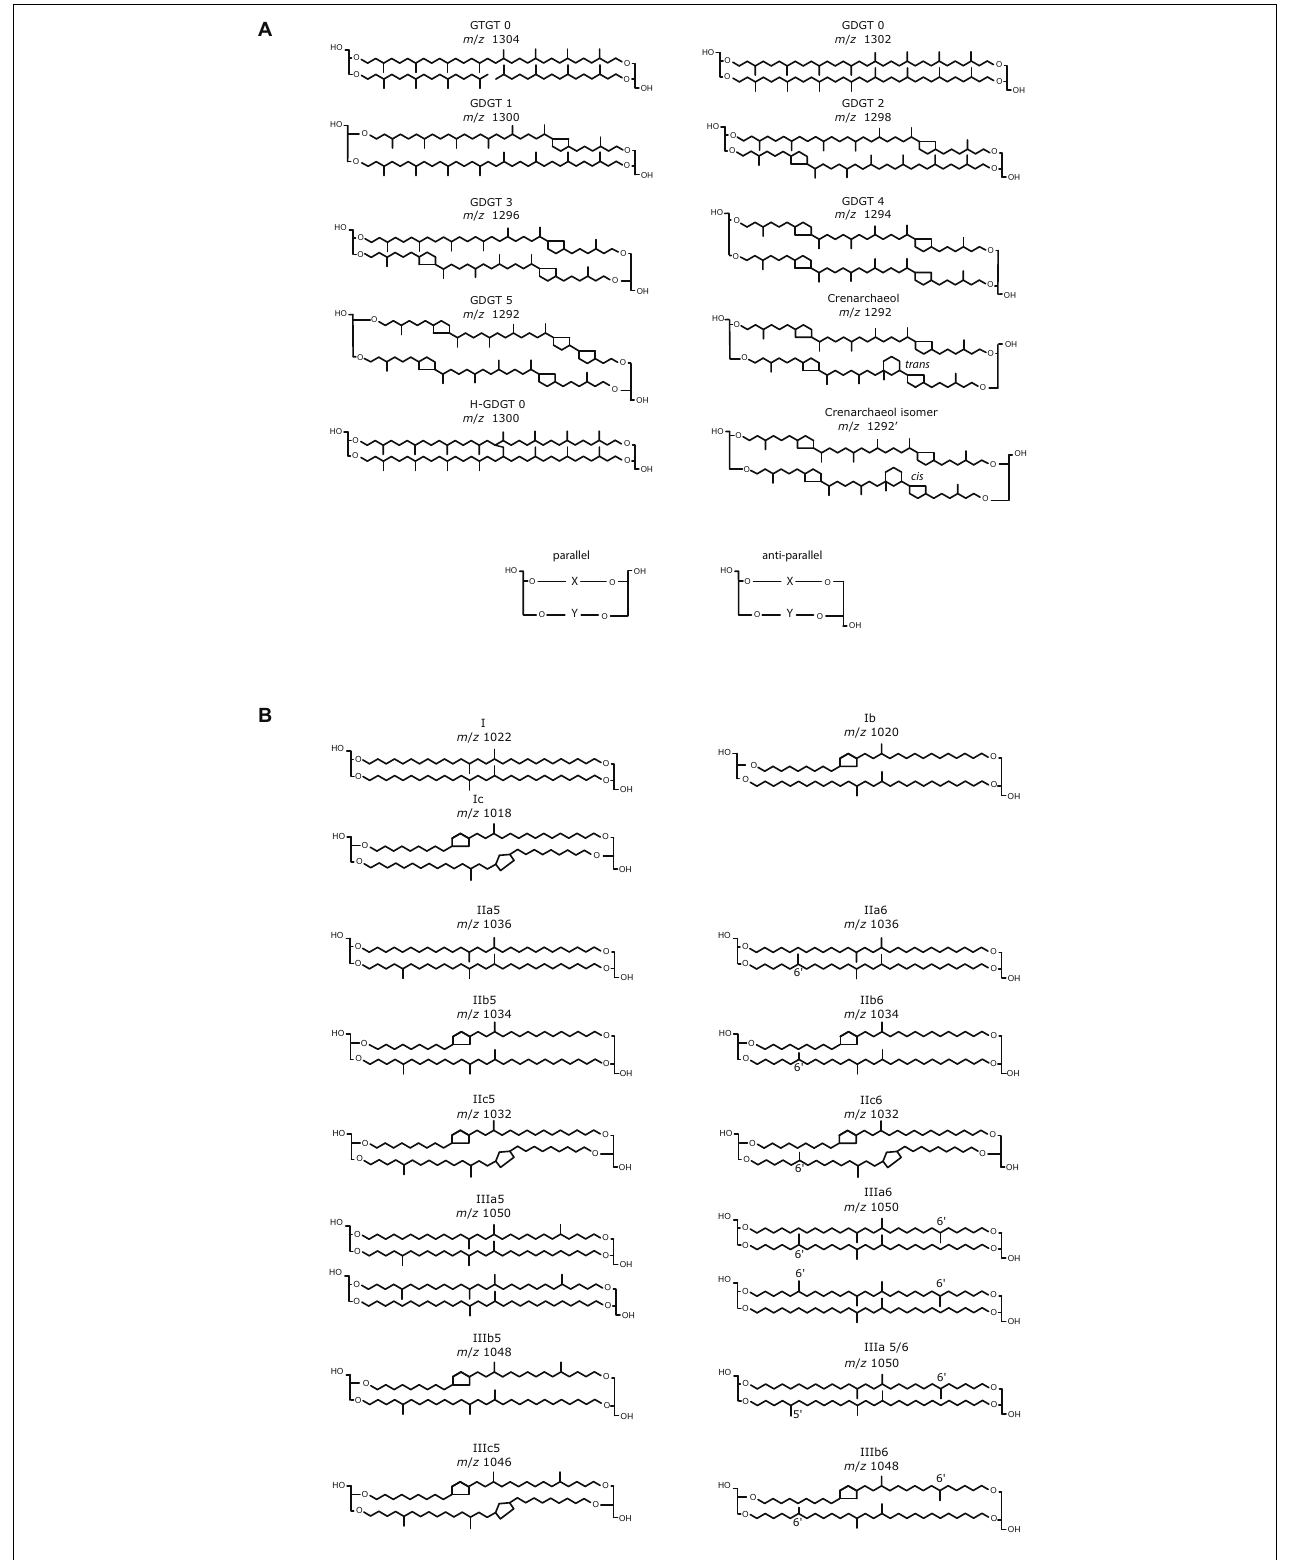
FIGURE 1 | Structures of (A) isoprenoid and (B) branched GDGTs including masses and common annotation found in the literature (Schouten et al., 2013b; De Jonge et al., 2014a). Note that this overview is not extensive and a large range of additional isomers are not shown (Liu et al., 2012b).